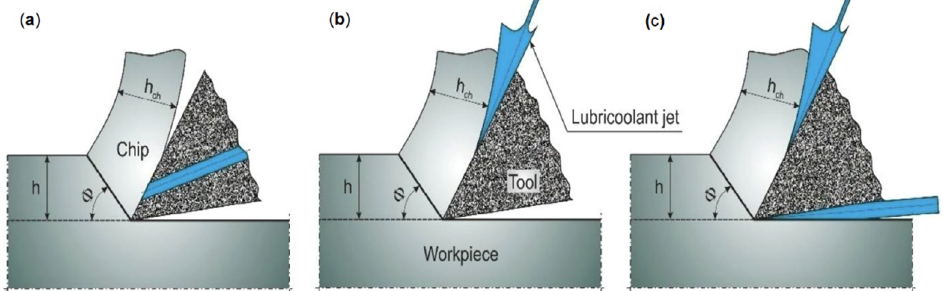
Figure 4. The methods of supplying a lubricating medium to the work–tool interface, inserted from: ( a ) from the side of the rake face; ( b ) on the rake face; ( c ) on the flank and rake face [39].